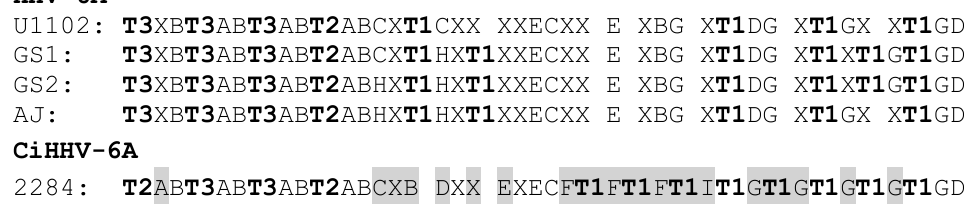
Figure 6. Structure of the imperfect telomeric repeat region at the UL-DRR junction. Perfect telomeric repeats are the related complement [9] in the inverse orientation in the reference genome, TAACCC, and the adjacent copy numbers are indicated as T1–T3. Imperfect telomeric repeats are represented by “ A ” for TAGGTC; “ B ” TAGCCC; “ C ” TAACCA; “ D ” TAACCG; “ E ” TAACAC; “ F ” TAACAA; “ G ” TAGCCA; “ H ” TAACTA; “ I ” TAGCAA and “X” for unrelated hexamers. Shading indicates rearranged hexamers.